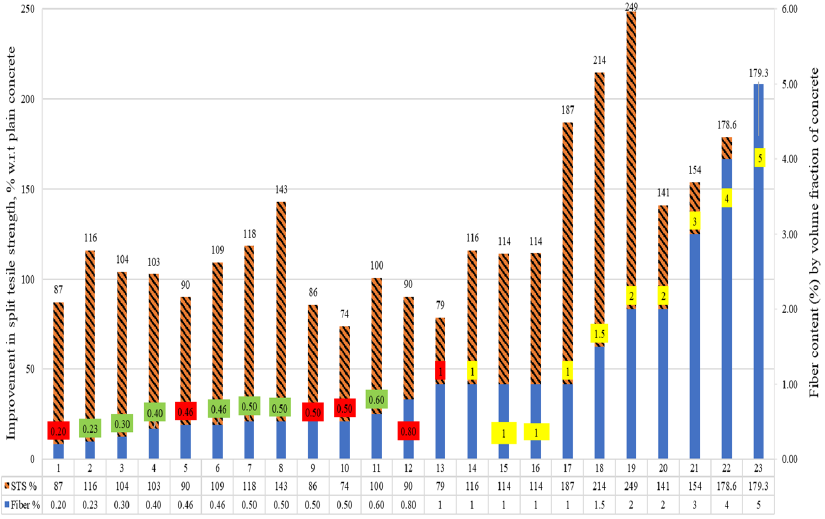
Figure 8. Percentage comparison of split tensile strength of concrete containing RSF by volume fraction.